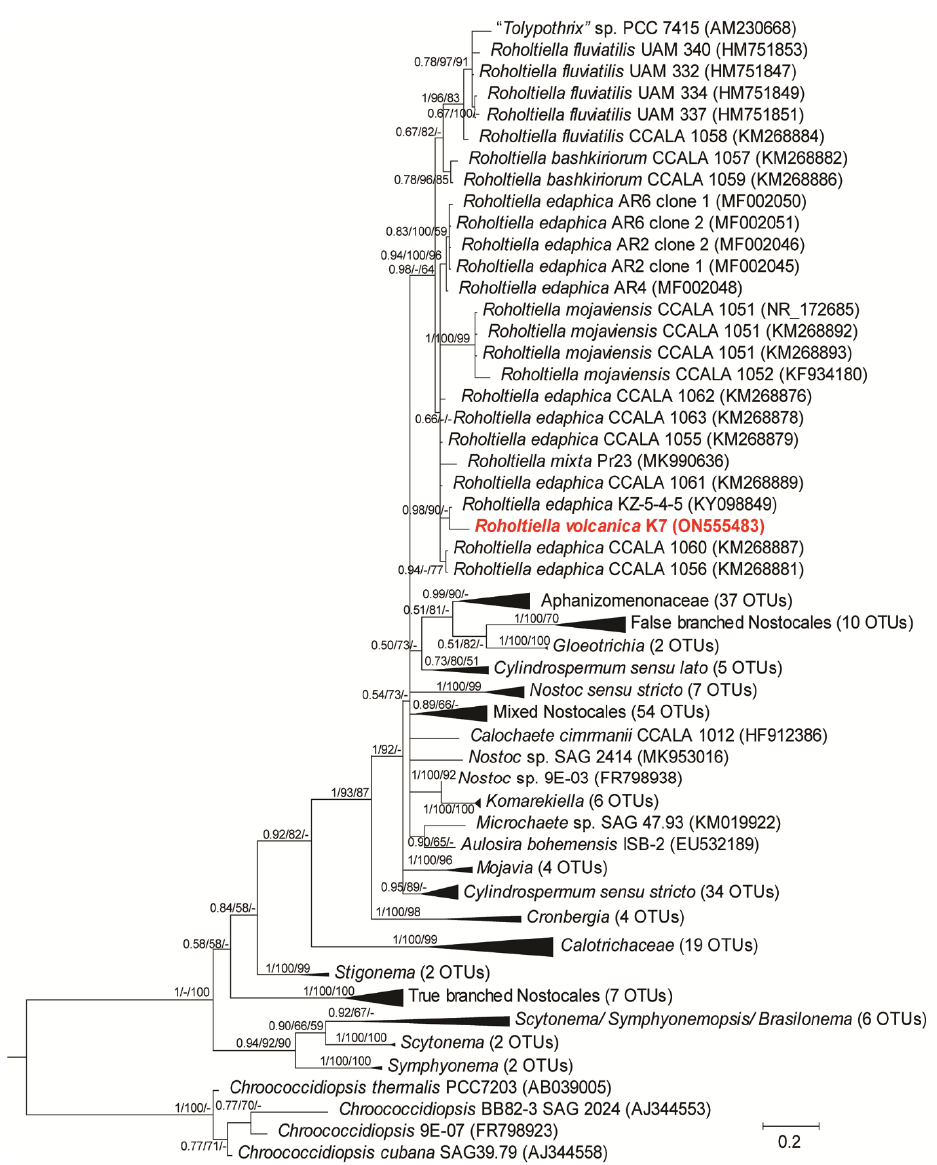
Figure 2. Phylogenetic positioning of Roholtiella volcanica K7 (in red font) based on the 16S rRNA gene sequence of 240 cyanobacterial taxa in the Nostocales, rooted with Chroococcidiopsis , with the posterior probability/bootstrap values representing BI/ML/NJ mapped on to the nodes in BI analysis. Bar, 0.2 changes per nucleotide position.